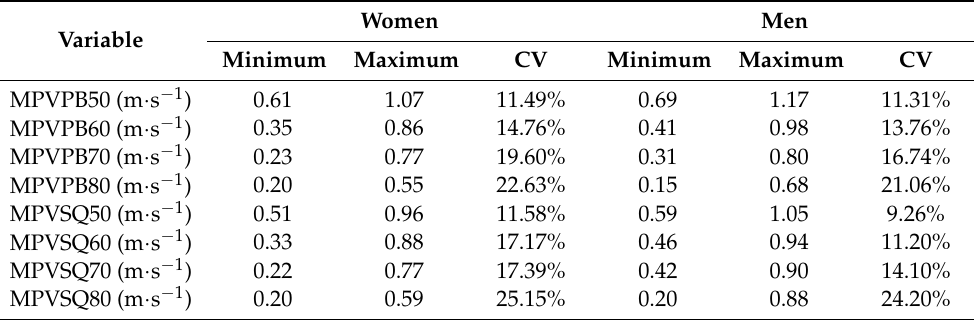
Table 2. Maximum and minimum values and coefficient of variation of the MPV at the different percentages of 1RM in the bench press and full squat.